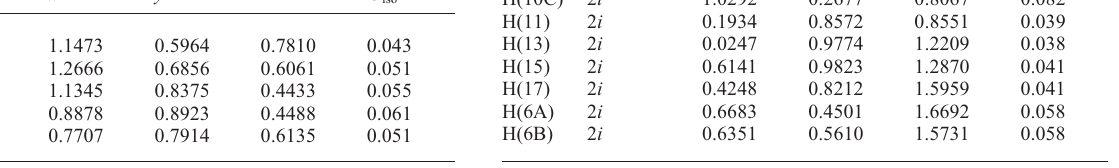
Table 3. Atomic coordinates and displacement parameters (in Å 2 )